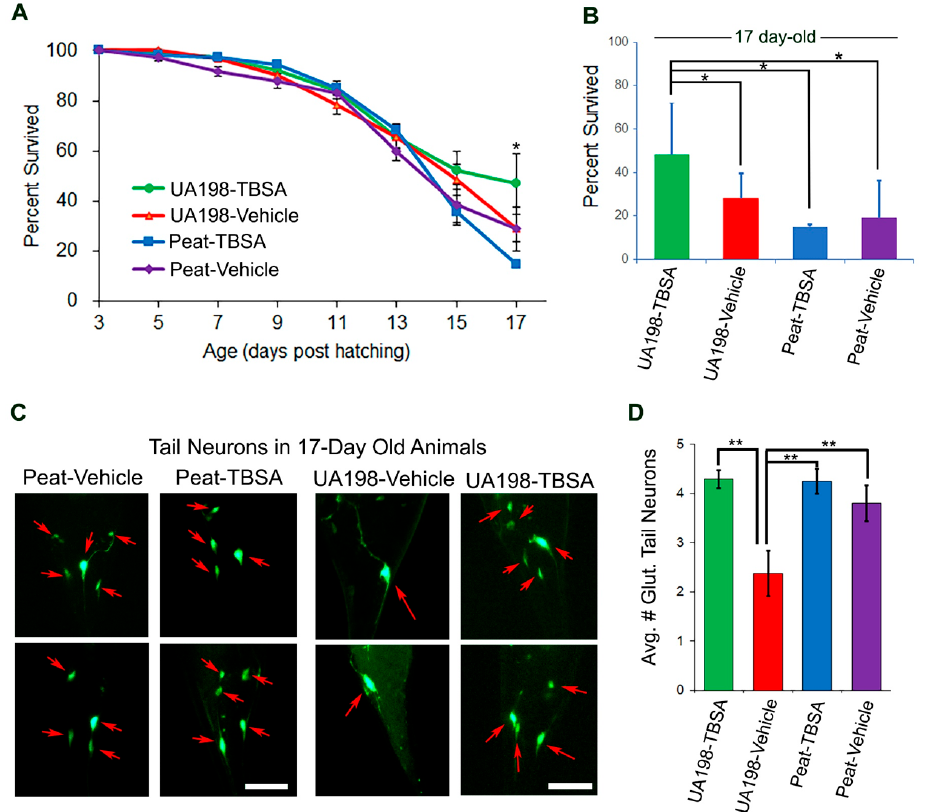
Figure 2. Treatments of trans-beta-styryl-boronic acid (TBSA) compound improved survivability and reduced neurodegeneration in a C. elegans model expressing A β 42. The C. elegans expressing A β 42 in their glutamatergic neurons (UA198) and age-matched controls (Peat-4::GFP) were treated with 10 µ g / mL TBSA or vehicle every two days out to 17 days old. ( A ): Survival was assessed every two days as a mean percent survived and plotted in a survival analysis curve (* p < 0.05 UA198 + TBSA in comparison to all other groups). Starting population per group, n = 61. ( B ): Survival was improved in aged (17-day-old) TBSA-treated C. elegans model expressing A β 42 (UA198) compared to untreated animals, and compared to treated and untreated Peat-4::GFP control animals (one-tailed t-test, * p < 0.05). ( C ): Representative images show two examples of GFP-expressing glutamatergic neurons in the tails of Peat-4::GFP controls, and UA198 C. elegans expressing A β 42, when untreated (Vehicle) or treated (TBSA), at 17 days of age. In addition to increasing cell survival, the TBSA treatment tended to preserve normal neuronal size and morphology. Magnification = 400x; scale bar = 20 µ m. ( D ): The mean number of surviving tail neurons in the tails of Peat-4::GFP controls, versus UA198 C. elegans expressing A β 42, when untreated (Vehicle) or treated with TBSA, at 17 days of age. The average tail neuron number in TBSA treated UA198 C. elegans expressing A β 42 was significantly greater than in the untreated animals (one-tailed t-test, ** p < 0.01; n = 15). Error bars denote standard error of mean (SEM) in all